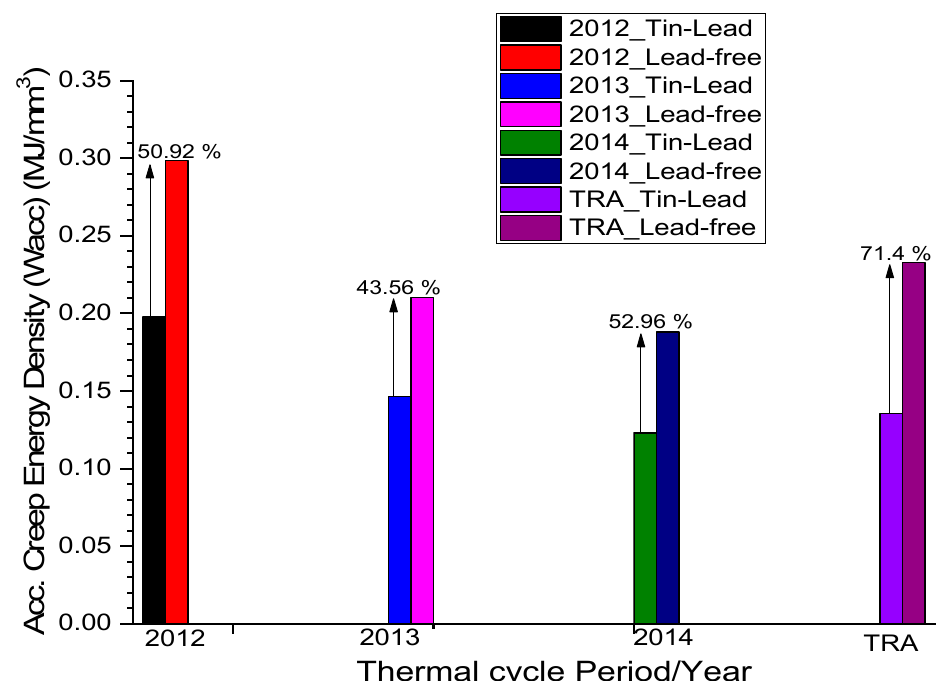
Figure 13. Column distribution of accumulated creep energy density for 2012, 2013, 2014 and TRA thermal cycles.